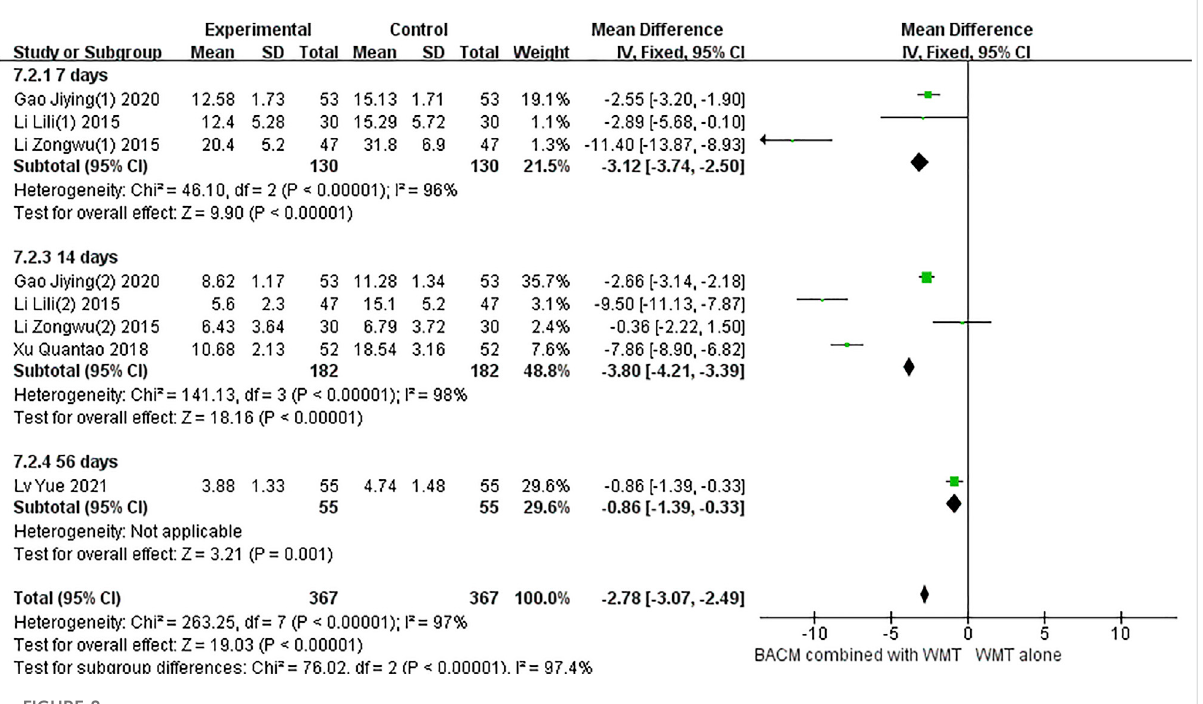
FIGURE 8 The forest plot of the volume of cerebral edema by BACM for ICH.